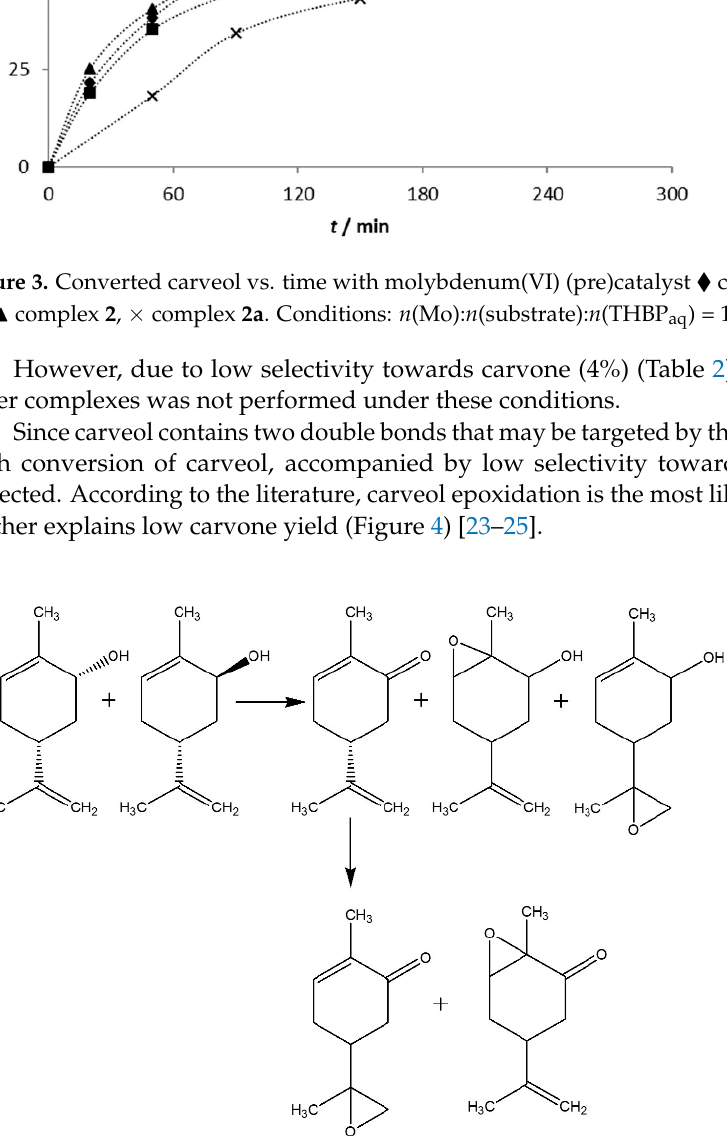
Figure 5. The extracted part of 1 H NMR spectra: (left) mixture of cis - and trans - carveol, reaction mixture with ( a ) H 2 O 2 or ( b ) THBP aq in the presence of complex 2 .